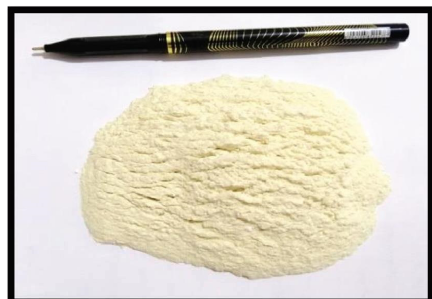
Figure 2: Commercially produced powder of pectin, extracted from citrus